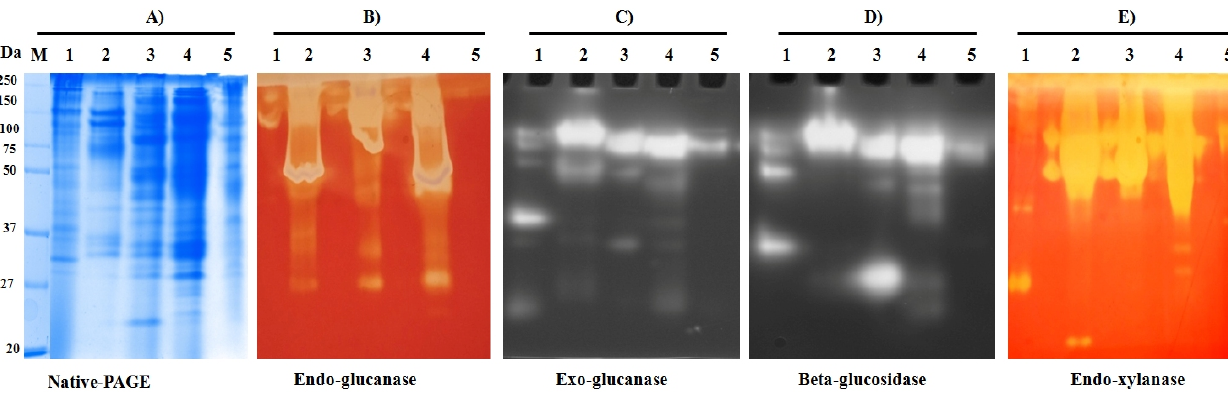
Figure 6. Native PAGE and zymogram analysis of cellulases and xylanase produced by Colletotrichum sp. OH. ( A ) A 10% PAGE gel and zymogram of ( B ) endoglucanase, 1% CMC; ( C ) exoglucanase, 5 μ M MUC; ( D ) β -glucosidase, 5 μ M MUG; and ( E ) endoxylanase, 1% xylan as substrates. Lane (M), molecular weight markers; lane 1, carboxy-methylcellulose (CMC); lane 2, Avicel (Av); lane 3, oil cake (OC); lane 4, rice husk (Rh); and lane 5, glucose (Gl).